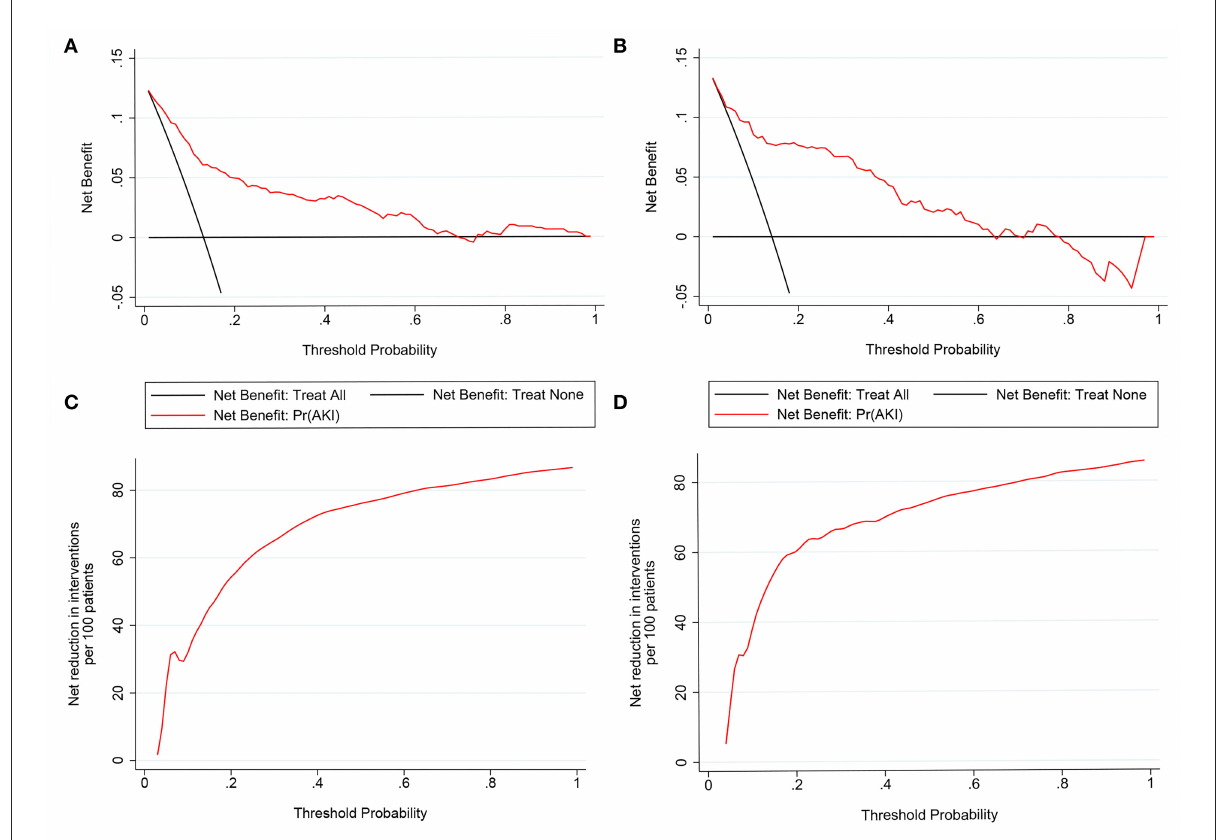
FIGURE5 Decision curve analysis (DCA) of the nomogram in the training set (A) and the validation set (C) . The horizontal line indicates no patients develop acute kidney injury (AKI), and the gray oblique line indicates patients develop AKI. The blue solid line represents the AKI risk nomogram. In DCA, the nomogram shows a more net benefit than full or no treatment across a threshold probability range. Interventions avoided the curve of the nomogram in the training set (B) and the validation set (D) . The curve represents the net reduction in the number of interventions per 100 patients at a given